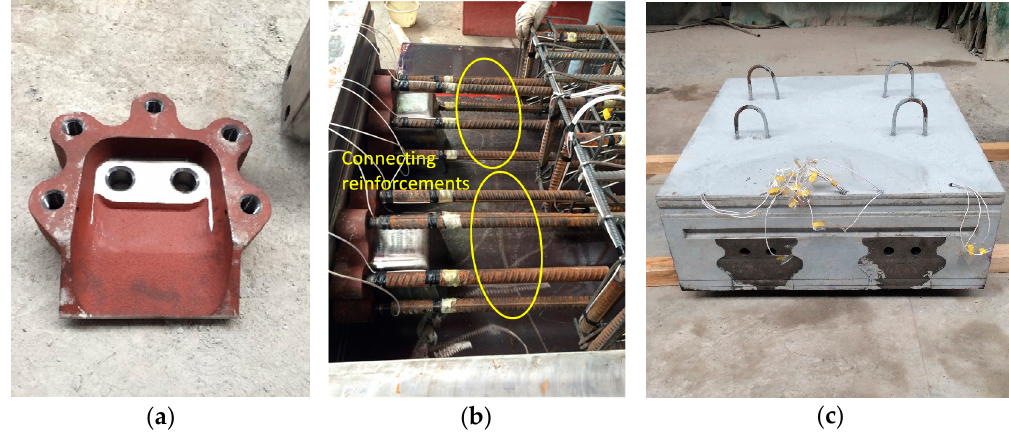
Figure 3. Tested segments: ( a ) ductile iron joint panel (DIJP); ( b ) connecting reinforcements; ( c ) segment after curing.